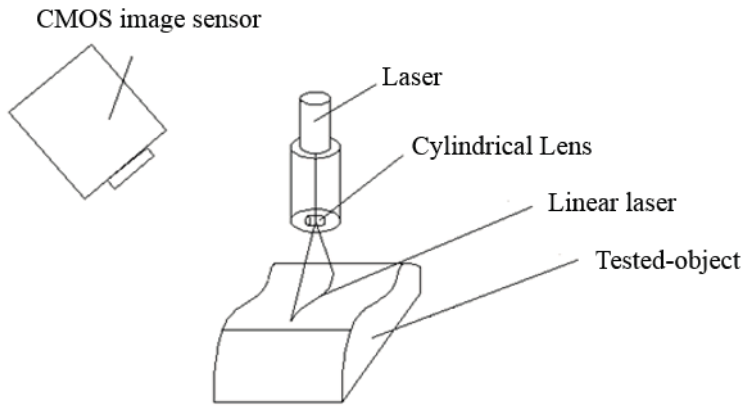
Figure 4. Projecting a linear laser on the tested